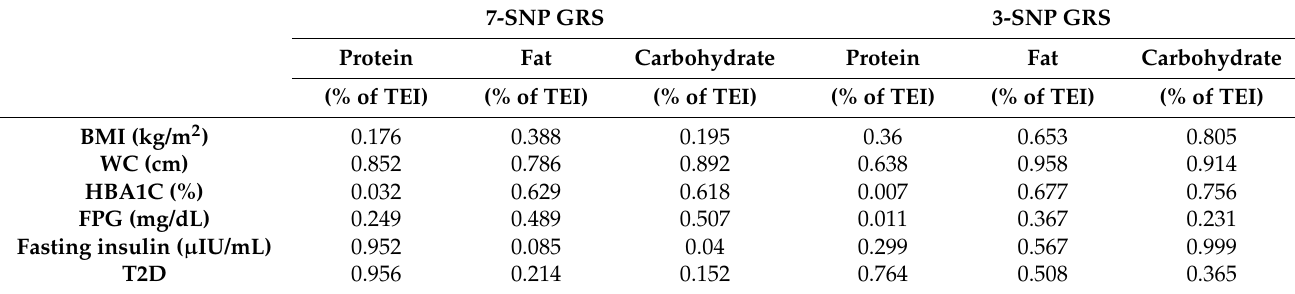
Table 4. Interactions of 7-SNP and 3-SNP GRSs with dietary factors on metabolic